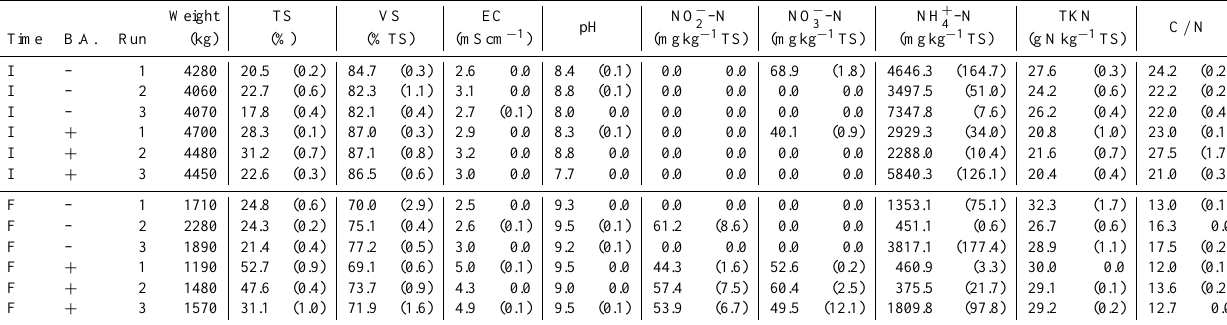
Table 1. Chemical components of compost samples.